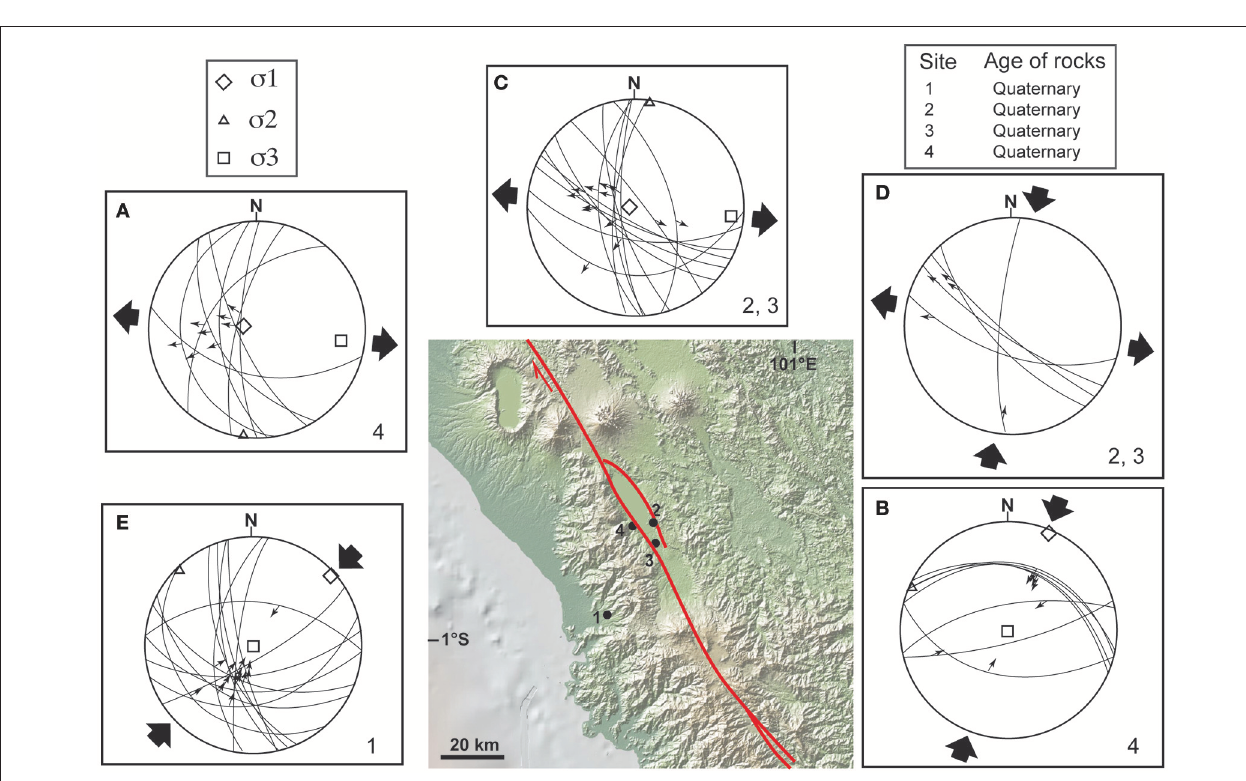
an arc-oblique (WNW-ESE striking) extension, mainly activating NNW-SSE dextral transtensive faults (plot I; Figure 10 ). As the fault slip data of the latter event are seen both at the contact and within the Holocene deposits, the NNW-SSE transtensive dextral faults correspond to the present-day kinematics. Most of